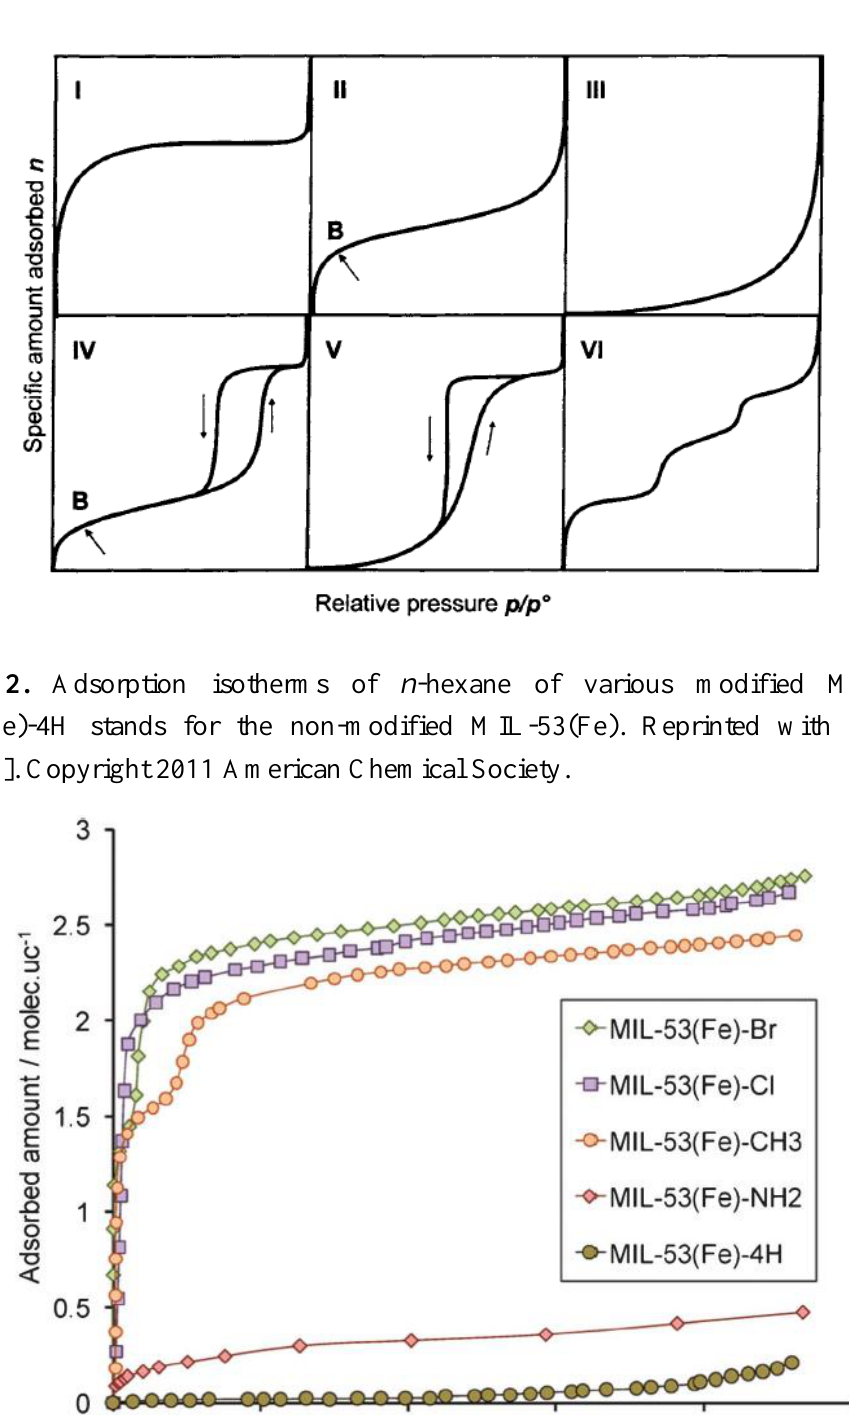
Figure 11. Six types of gas physisorption isotherms. Reprinted with permission from [100]. Copyright 1985 IUPAC.